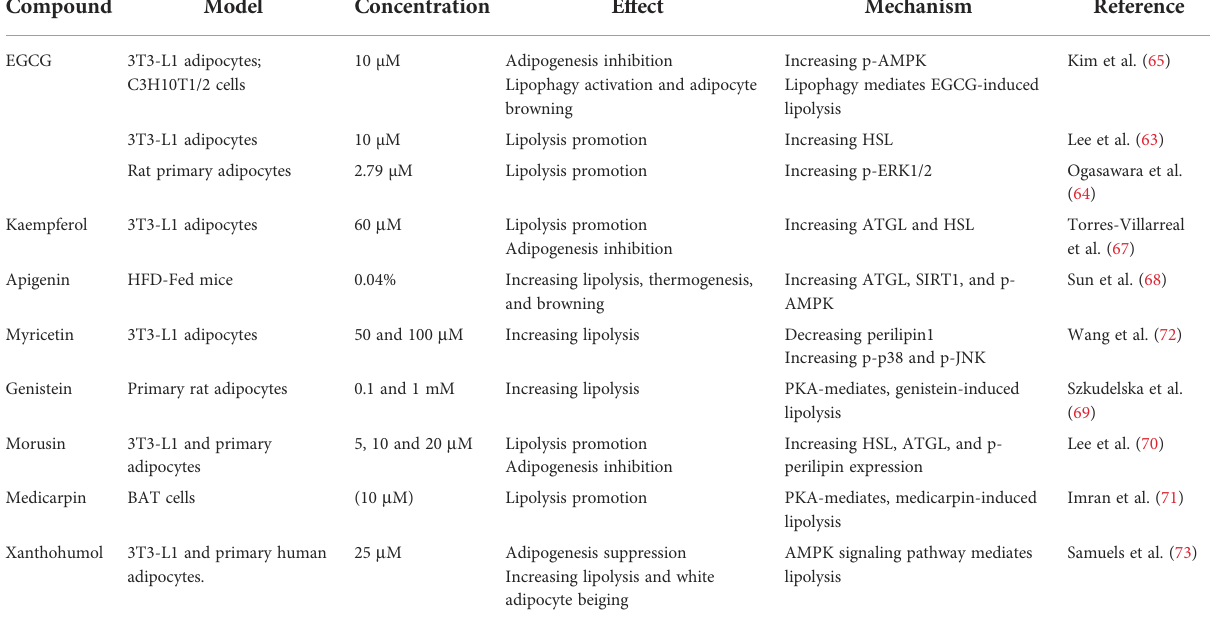
TABLE 1 Lipolytic effects and modes of action of fl